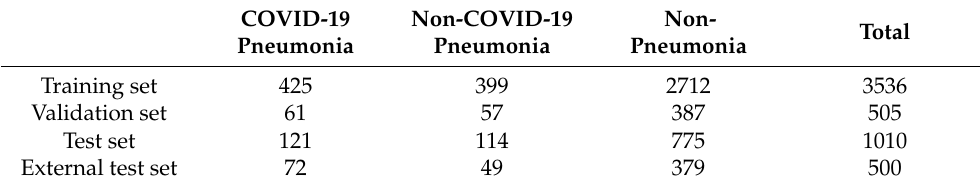
Table 1. Statistics of training, validation, test, and external test